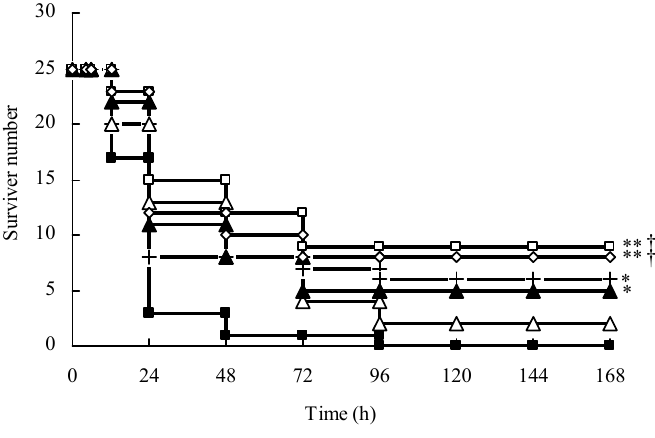
Figure 1. Protection of AS in combination with AMPS on CLP mice. One hundred and fifty mice was randomly divided into six groups ( n = 25) and treated as follows: ■ , CLP group; +, CLP and AS (30 mg/kg) alone; ∆ , CLP and AMPS (100 mg/kg); ◊ , CLP and AS (7.5 mg/kg) in combination with AMPS; □ , CLP and AS (15 mg/kg) in combination with AMPS; and ▲ , CLP and AS (30 mg/kg) in combination with AMPS. AS and AMPS was repeatedly administered at 0, 4, 24, and 48 h after CLP operation. The mice were fed ad libitum and the mortality was observed for seven days. * p < 0.05, ** p < 0.01 as compared to CLP group; † p < 0.05 as compared to CLP and AMPS group. Other details are as described under Materials and